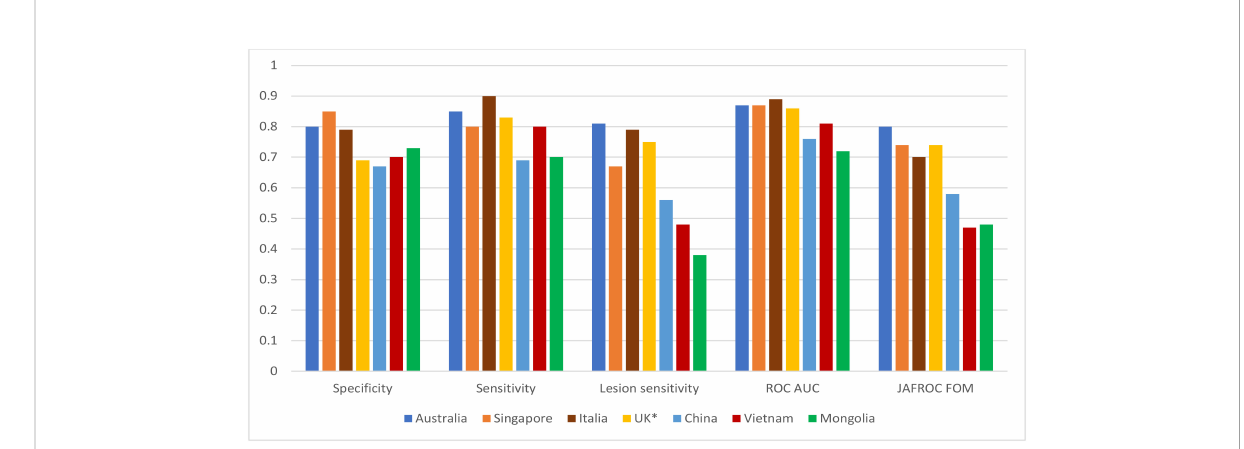
FIGURE 5 Diagnostic performances of radiologists in different countries in full- fi eld digital mammogram BREAST test sets. *: Reporting